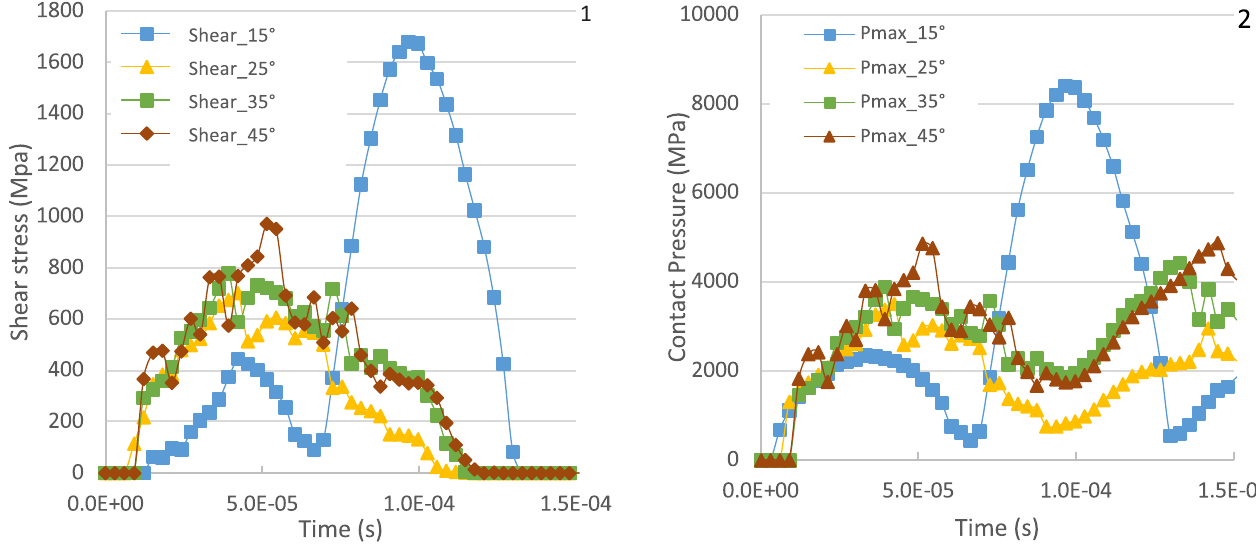
Fig. 23. Valve-seat contact shear stress (1) and pressure (2) for different